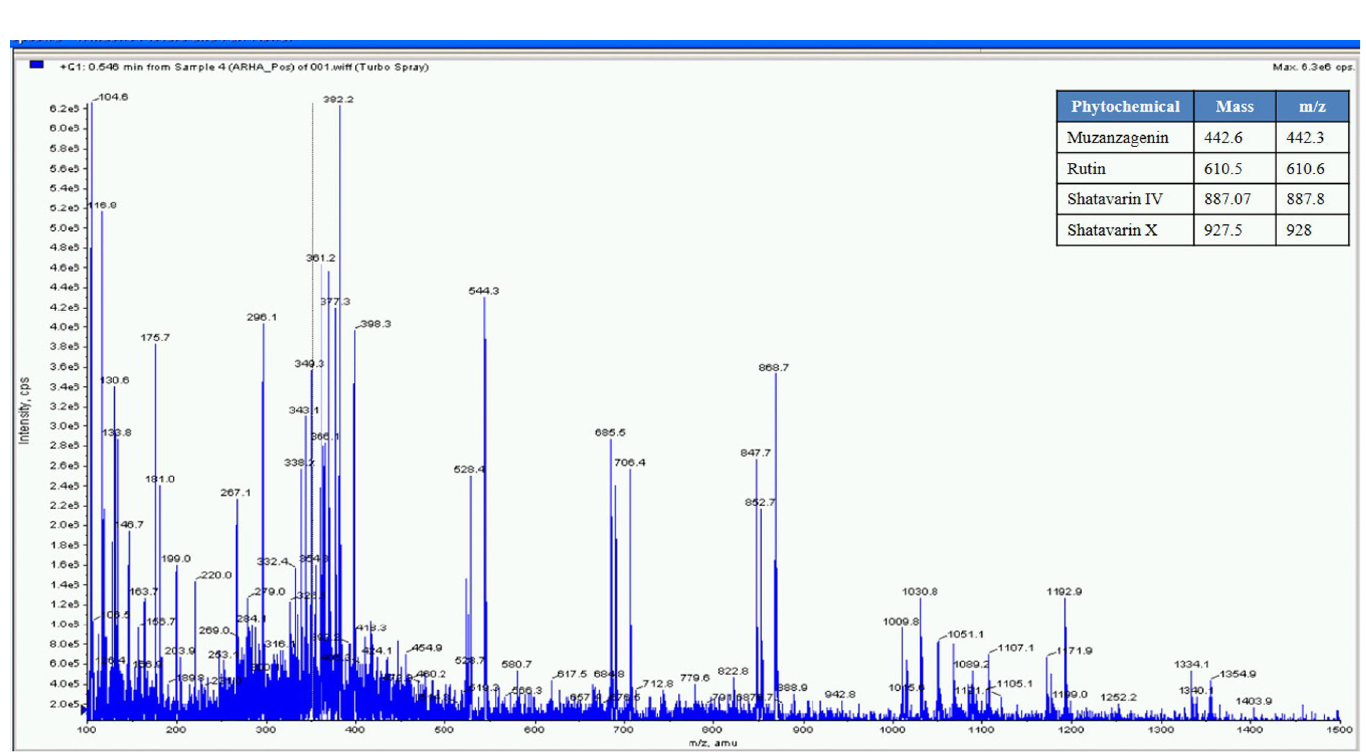
Fig 9. Mass spectrometer fingerprint of Asparagus racemosus hydro-alcoholic extract (ARHA). https://doi.org/10.1371/journal.pone.0248479.g009 PLOS ONE | https://doi.org/10.1371/journal.pone.0248479 June 11,